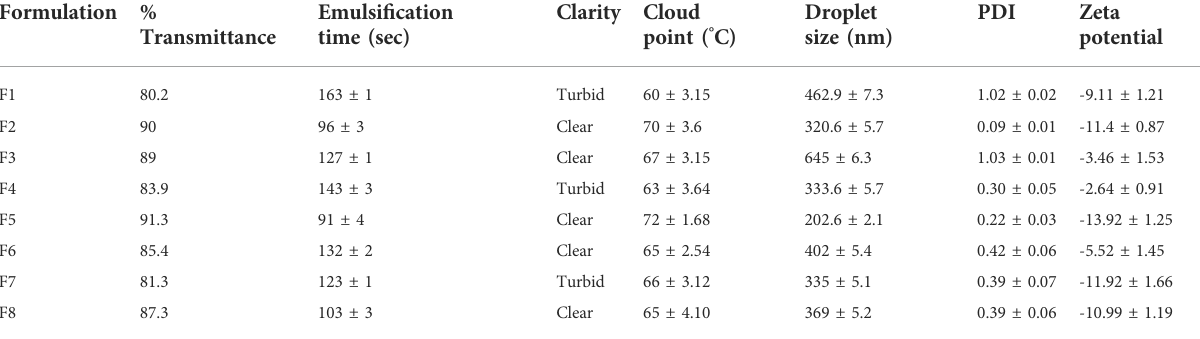
TABLE 4 Percentage transmittance, emulsi fi cation time, clarity, cloud point, globule size, zeta potential, and polydispersity index data are presented as means (n = 3) ±SD. Formulation %